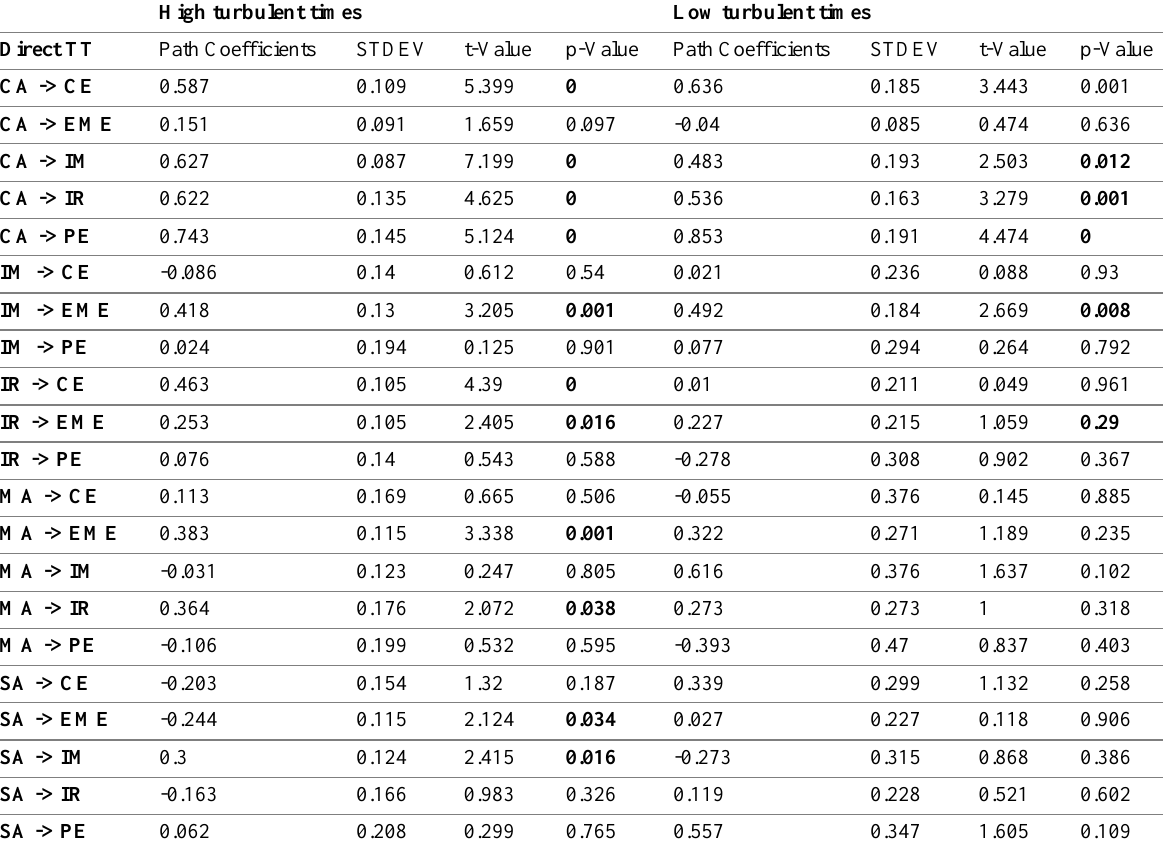
Table 9: Multi-group analysis for Turbulent times (direct